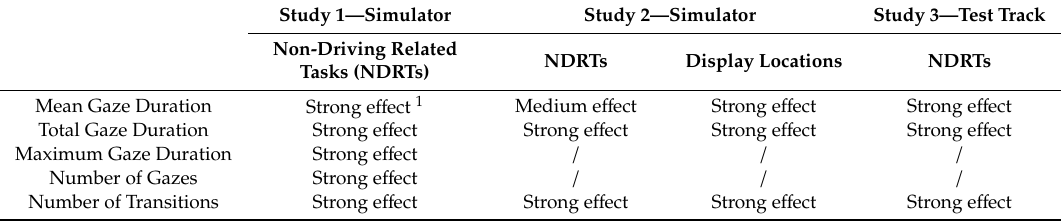
Table 4. E ff ects of the parameters used to examine supervisory capabilities across the three studies.